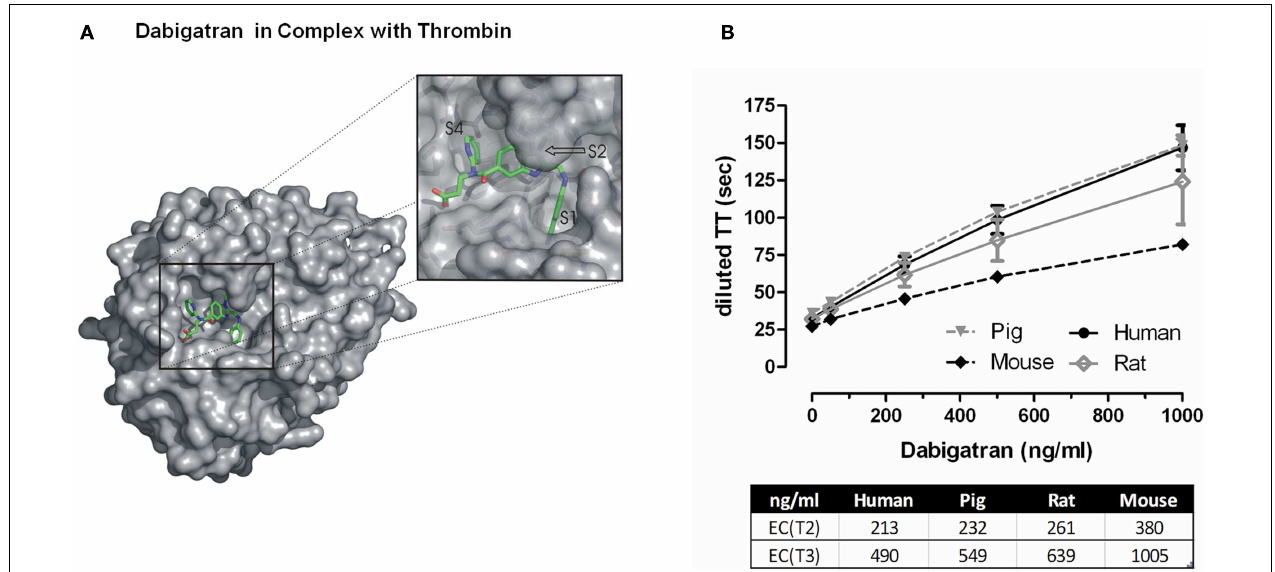
occupies the S4 pocket with its pyridyl ring that forms an edge-on CH ... π interaction withTrp-215 at the floor of the pocket and places its propionic acid group into the solvent exposed S3 pocket. (B) Effect of increasing concentrations of dabigatran on diluted thrombin time measurements in different species.The EC( T 2) and EC( T 3) represent the effective concentration of dabigatran to prolong the clotting time either twofold or threefold. Data represented as mean ± SE, n =